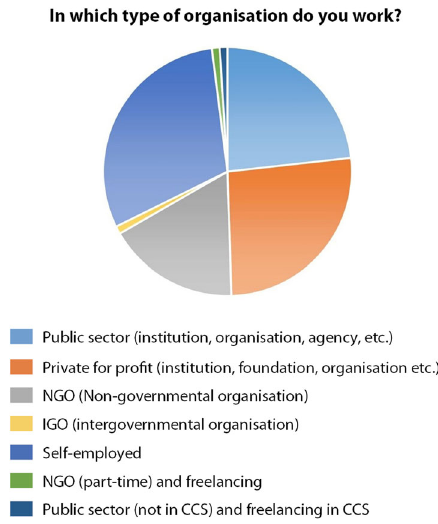
Fig. 8 In which type of organisation do you work? (Source: the authors)